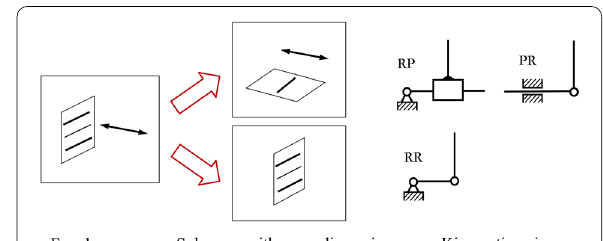
Figure 7 Kinematics pair corresponding to the freedom space of the grasping